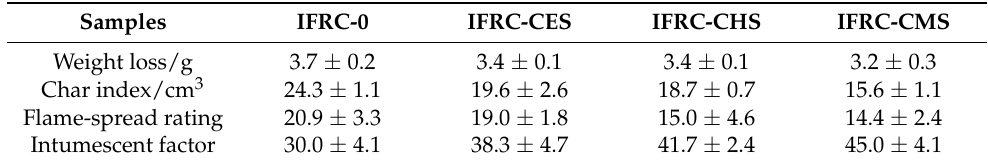
Table 3. Fire protection performances of IFRCs.